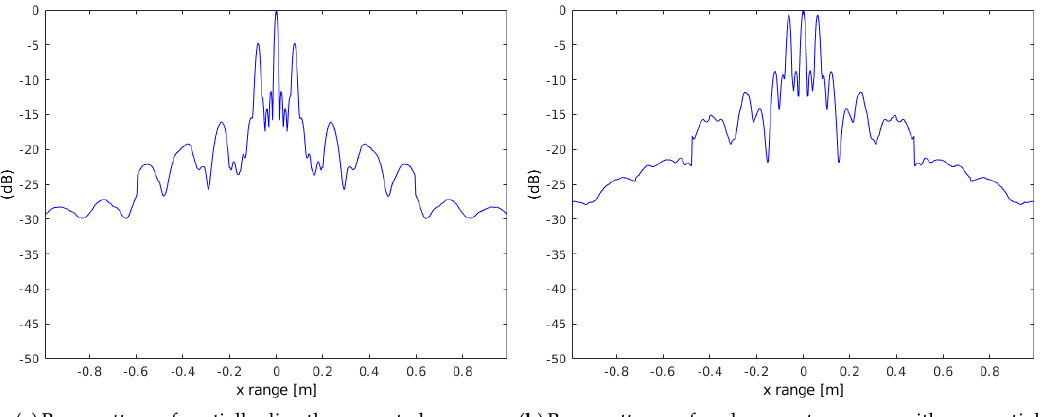
Figure 5. Comparison of image reconstruction (beampattern from point scatterer) using different distances between array